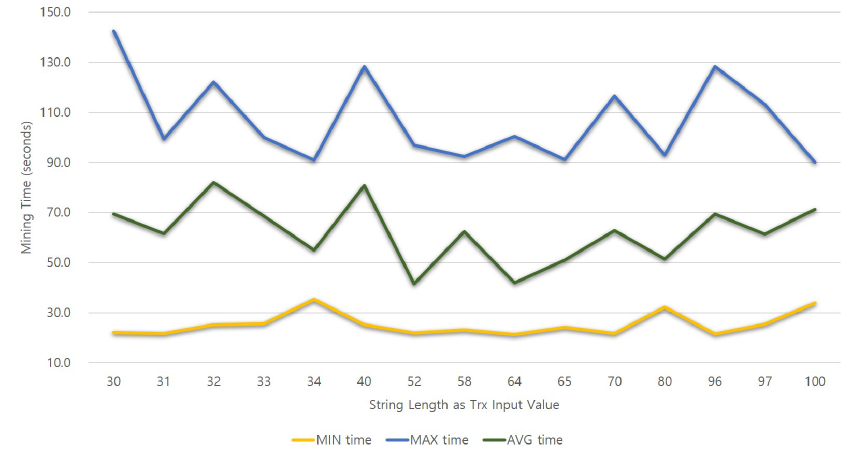
Figure 9. Change of mining time with different input lengths of